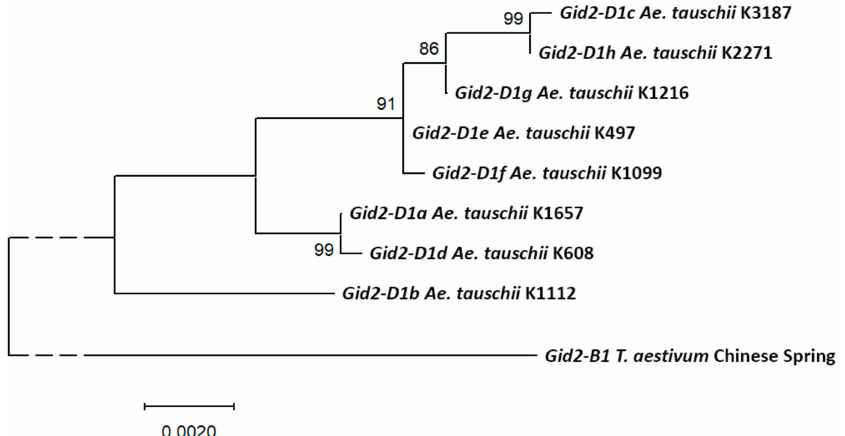
Figure 3. Molecular phylogenetic tree of the Gid2-D alleles of Ae. tauschii , constructed by the maximum-likelihood method. After the allele name, an example of the Ae. tauschii accession in which it was detected is given. The percentage of trees in which associated alleles clustered together in 500 bootstrap replicates is shown next to the branches. The Gid2-B gene of the cv. Chinese Spring of common wheat was used as an